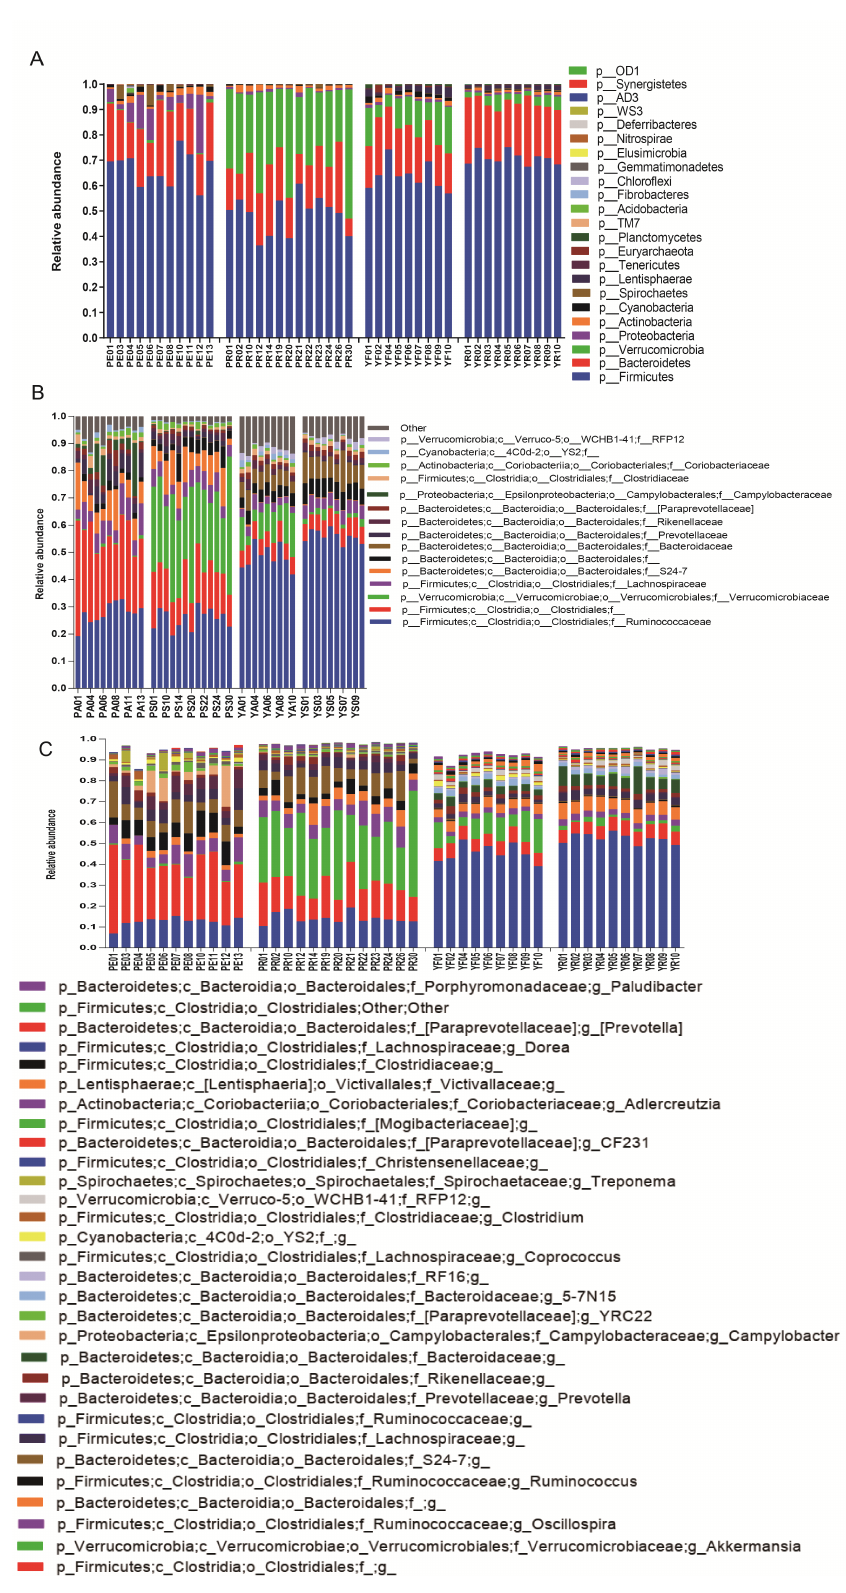
Figure 2. Composition of gut microbiota of plateau pikas and yaks in sympatry and allopatry. The “PA”: the pikas in the allopatric enclosure, “PS”: sympatric pikas with yaks, “YS”: sympatric yaks with pikas, and “YA”: yaks in allopatric farms. ( A ) Abundance of gut microbiota at phylum level. ( B ) Top 15 abundant gut microbiota at family level. ( C ) Top 30 abundant gut microbiota at genus